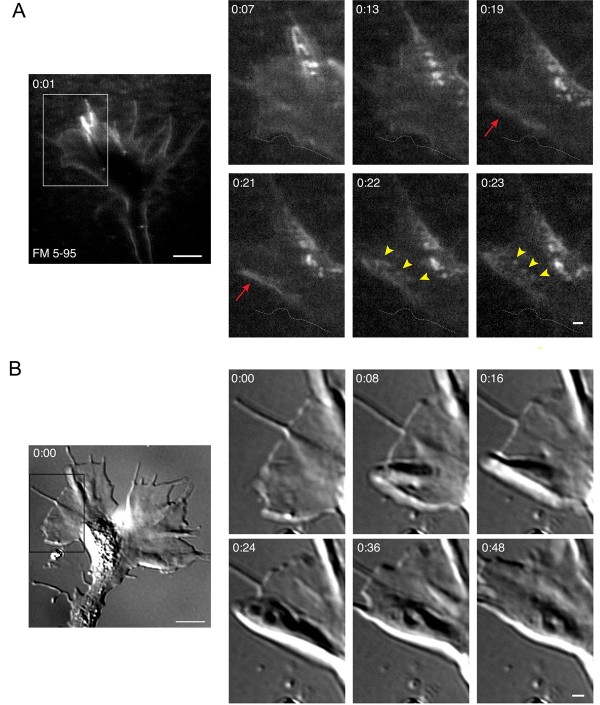
Small endocytic vesicle hot-spots at the lateral margins of lamellipodia. (A) Time-lapse confocal images of FM 5-95 internalization show endocytosis at the lateral margin of a lamellipodium as the growth cone narrows. The boxed area is magnified in the panels on the right and the time after the initial membrane labeling (minutes:seconds) is indicated in each frame. The static dashed line represents the lamellipodial margin at t = 0:07. In subsequent frames, the lamellipodium remodels to form a dye-rich membrane ruffle (red arrows, 0:19, 0:21). Within seconds, numerous small vesicles form (yellow arrowheads, frames 0:22, 0:23). The corresponding time-lapse movie is shown in Additional file 2. (B) Similar ridge formation at a lamellipodial lateral margin observed by time-lapse DIC microscopy. See Additional file 3 for the corresponding time-lapse movie. Scale bars, 5 μm (left), 1 μm (right).